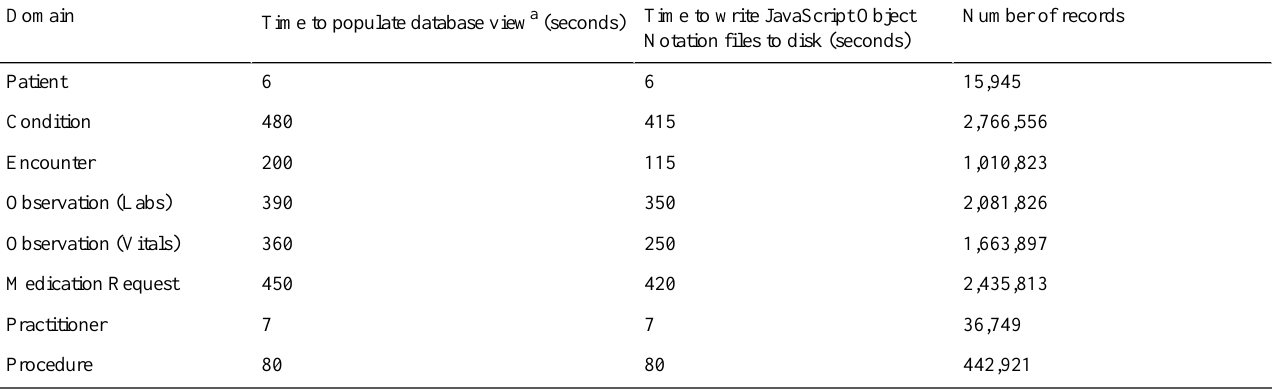
Table 5. Clinical Asset Mapping Program Fast Healthcare Interoperability Resources’s (CAMP FHIR) performance extracting data from the Patient-Centered Outcomes Research Network common data